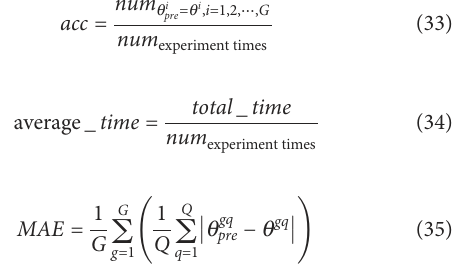
complexity of the algorithm. The MAE (35) can indicate the